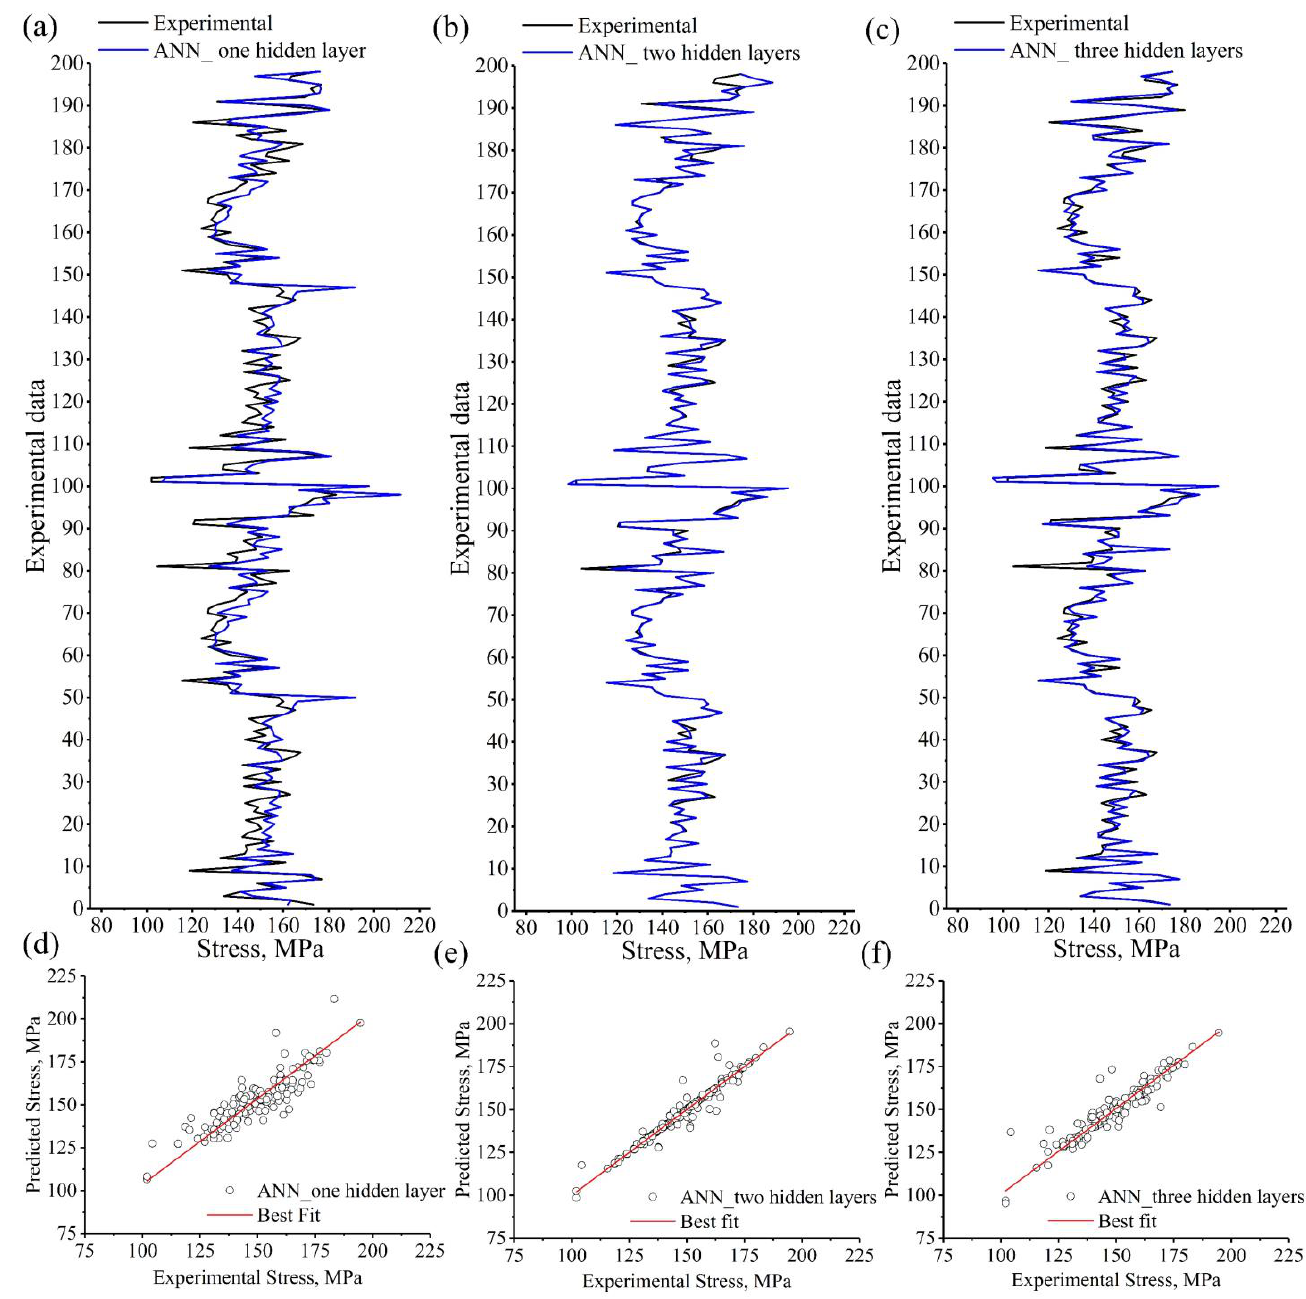
Figure 9. Experimental stress compared to the predicted stress of the ANN model with ( a , d ) one layer, ( b , e ) two hidden layers, and ( c , f ) three hidden layers.